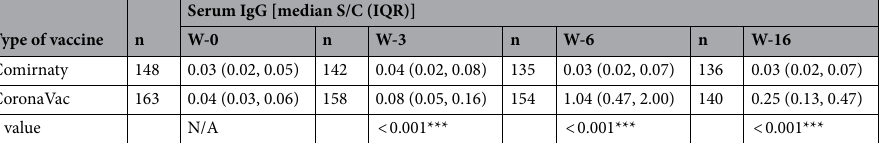
Table 4. Serum IgG-N antibody titers over time, based on the vaccine recipients. Samples (n), Signal/cutoff (S/C), and interquartile ranges (IQRs) indicate the minimum and maximum values. p value was set according to the Mann–Whitney U test. W-0, Week zero; W-3, Week three; W-6, Week six; W-16, Week 16. * p < 0.05; ** p < 0.01; *** p < 0.001.